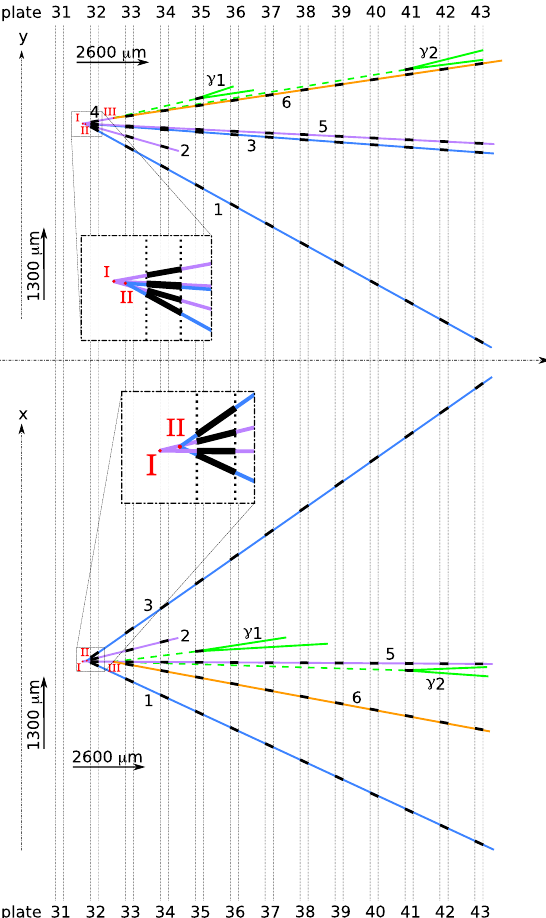
Fig. 5 Projected views, in film 31 to 43, of the event in the Y Z (upper plot) and XZ (bottom plot) planes. Tracks measured in single emulsion films are represented in black, while globally reconstructed tracks are represented using coloured lines: purple for tracks coming from the primary V I ,bluefortrackscomingfrom V II andorangeforthedaughter of vertex V III . Photon directions are reported with green dashed lines until their first electron-positron pair. Continuous green lines represent cones containing the electromagnetic showers (not to scale in X , Y ) Track 2 stops at film 34; track 3 undergoes a re-interaction at film 53, while tracks 1, 5 and 6 reach the CS films. The coordinates of the three vertices are listed in Table 2.